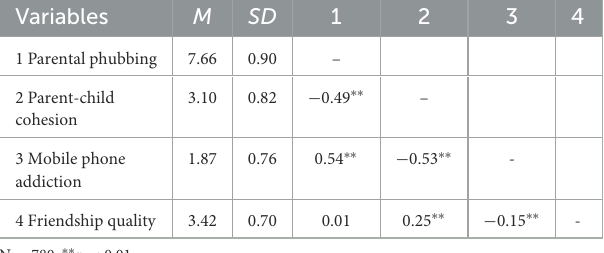
parental phubbing positively predicted mobile phone addiction, B = 0.53, p < 0.001 (Eq. 1). Second, parental phubbing negatively